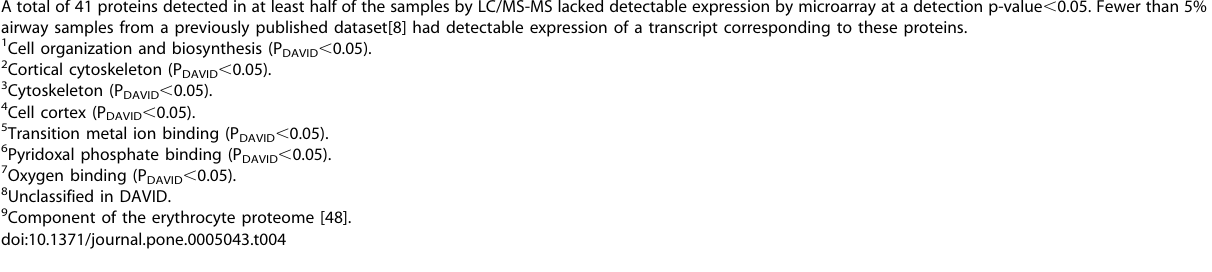
Table 4. Proteins detected in the airway by mass spectrometry that lack detectable transcript by microarray.